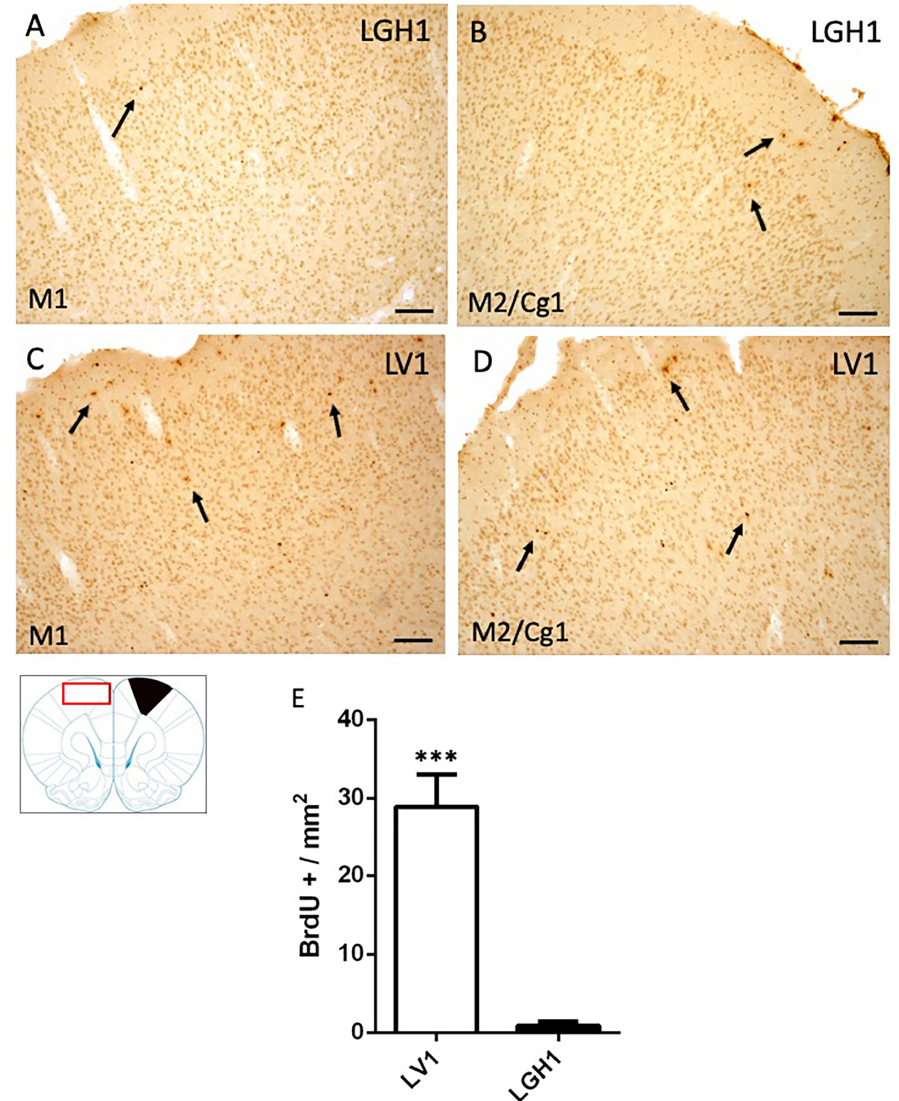
Figure 5. Cell proliferation in the contralateral motor cortex of animals sacrificed at 25 dpi. BrdU-ir in the contralateral motor cortex (red rectangle in the scheme) of animals treated with GH ( B ) or vehicle ( C , D ) at 25 dpi. ( A , C ), primary motor cortex (M1); ( B , D ), secondary motor cortex / cingulate cortex, area 1, (M2 / Cg1). Arrows point to some BrdU + cells. Coronal sections at + 2.52 mm from Bregma. The black region indicates where the ablation was produced. Scale bar = 100 µ m. ( E ) shows the significant increase in BrdU-labeled cells (mean + SEM, n = 2) observed in vehicle-treated animals compared to animals treated with GH *** p < 0.001 (Student’s t -test).